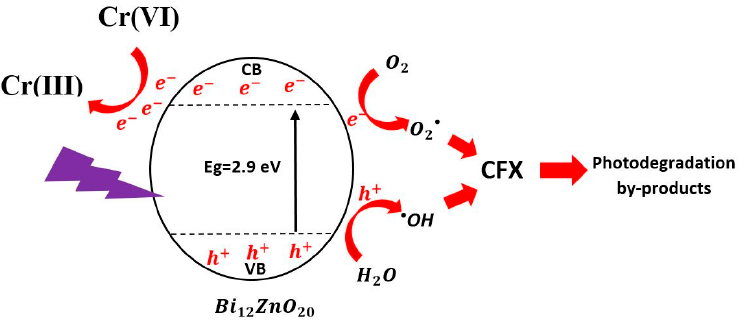
Figure 10. Possible mechanism of the photocatalytic removal of CFX and Cr(VI) using Bi 12 ZnO 20 . When a light source (energy more than the bandgap) is exposed and exceeds the photocatalyst, electrons (e − ) and holes (h + ) occur in the conduction band (CB) and valance band (VB), respectively [1]. These pairs are responsible for eliminating organic or inorganic pollutants through reduction and oxidation reactions